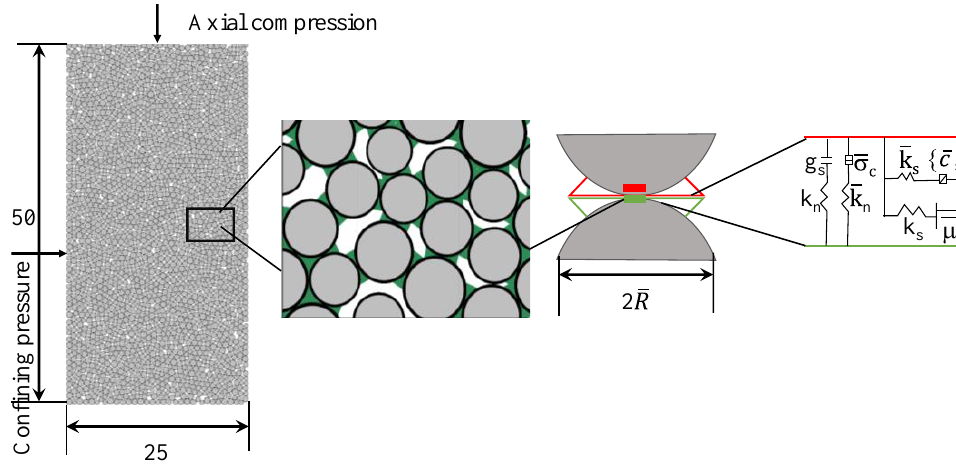
Figure 1. Numerical sample generated by PFC 2D.